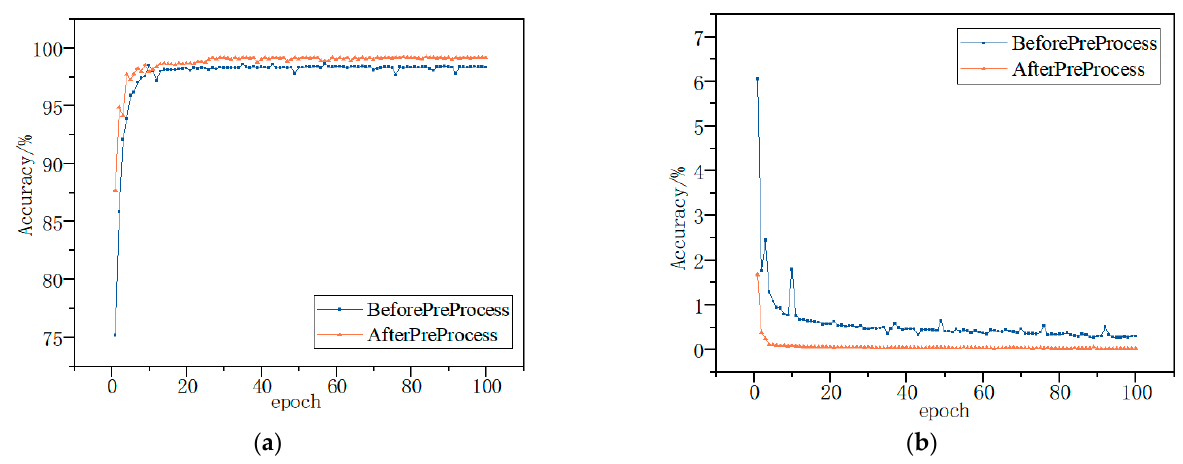
Figure 11. Kaggle dataset accuracy and loss; they should be listed as: ( a ) Description of accuracy; ( b ) Description of loss.